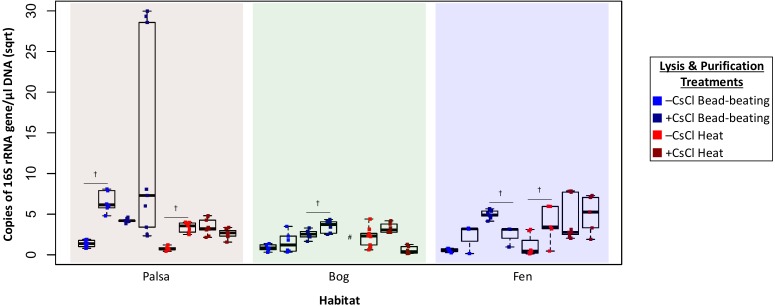
Evaluation of microbial contamination (Experiment 2).The 16S rRNA gene contamination (square root) is indicated for each virome grouped by habitat before (left) and after (right) clean up with PowerClean. The four treatments are color coded with blue for bead-beating and red for heat lysis and a darker shade after CsCl purification. # denotes no data available. 16S qPCR primers were 1406F-1525R, from Woodcroft et al. (2018)
† denotes significant difference for t test, p-value <0.05; ††, p-value < 0.01; †††, p-value < 0.001.